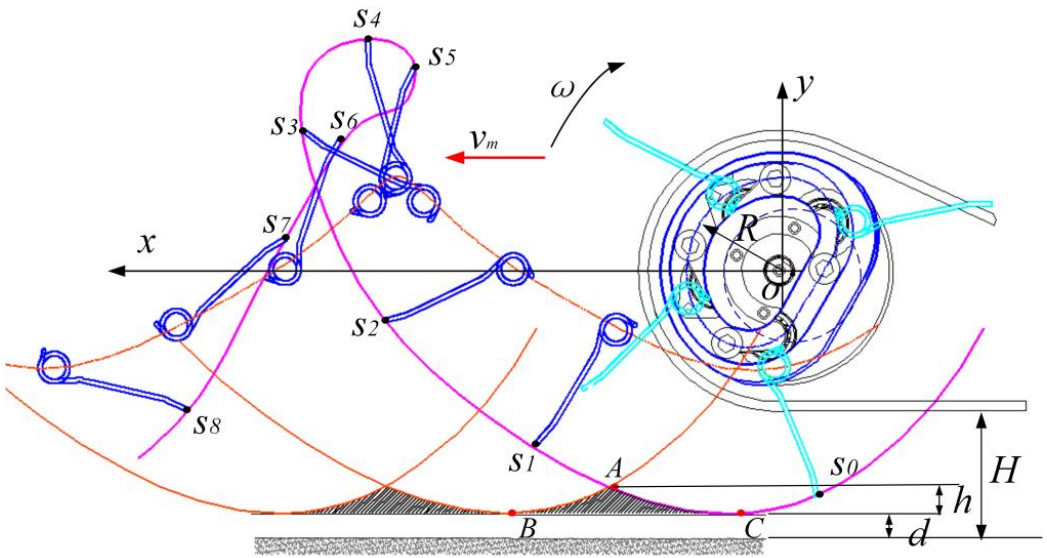
Figure 3. Motion track of picker.